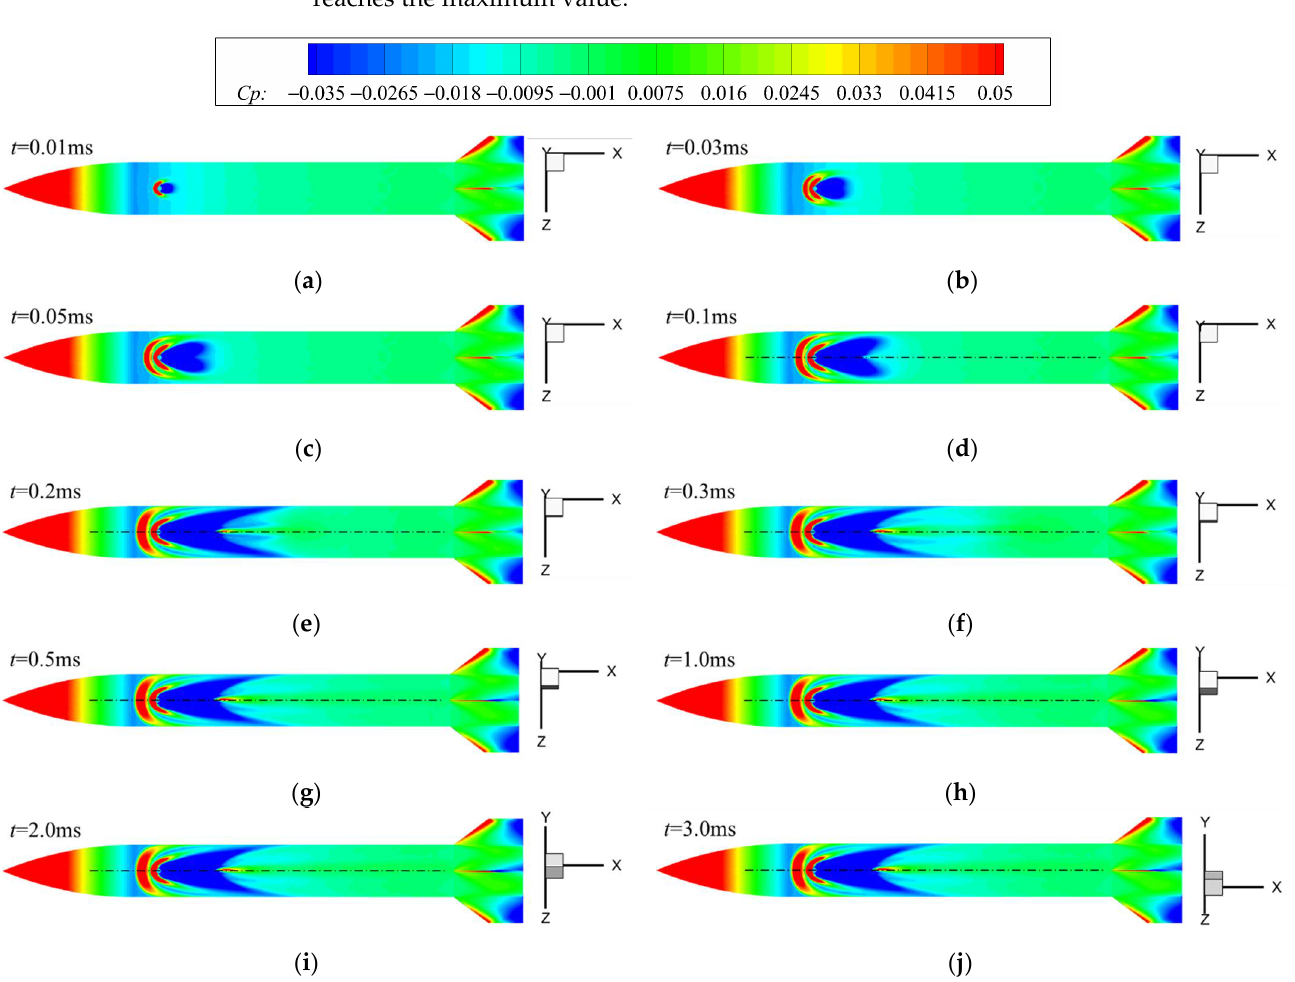
Figure 17. Pressure coefficient contours of the missile surface at different times since lateral jet startup: ( a ) t = 0.01 ms, ϕ = 0.21°; ( b ) t = 0.03 ms, ϕ = 0.63°; ( c ) t = 0.05 ms, ϕ = 1.06°; ( d ) t = 0.1 ms, ϕ